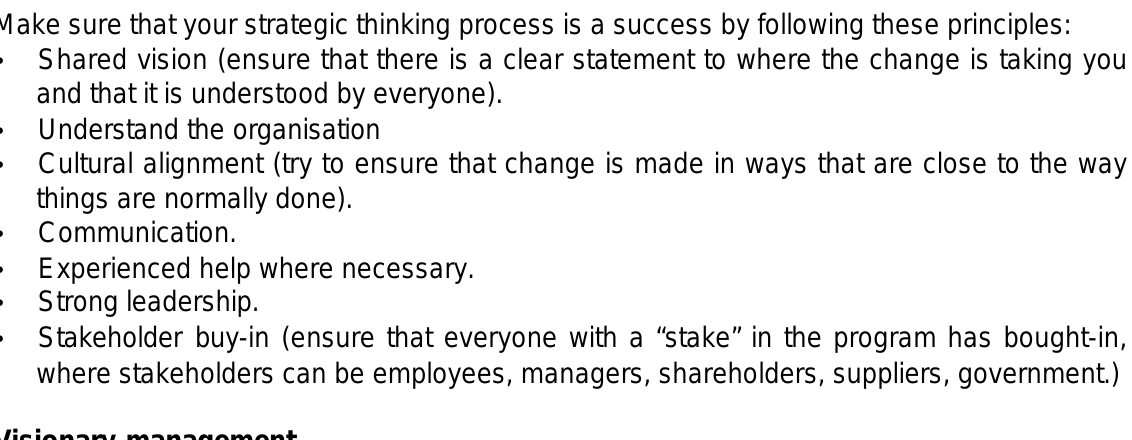
TABLE 3: CHARACTERISTICS OF LEARNING